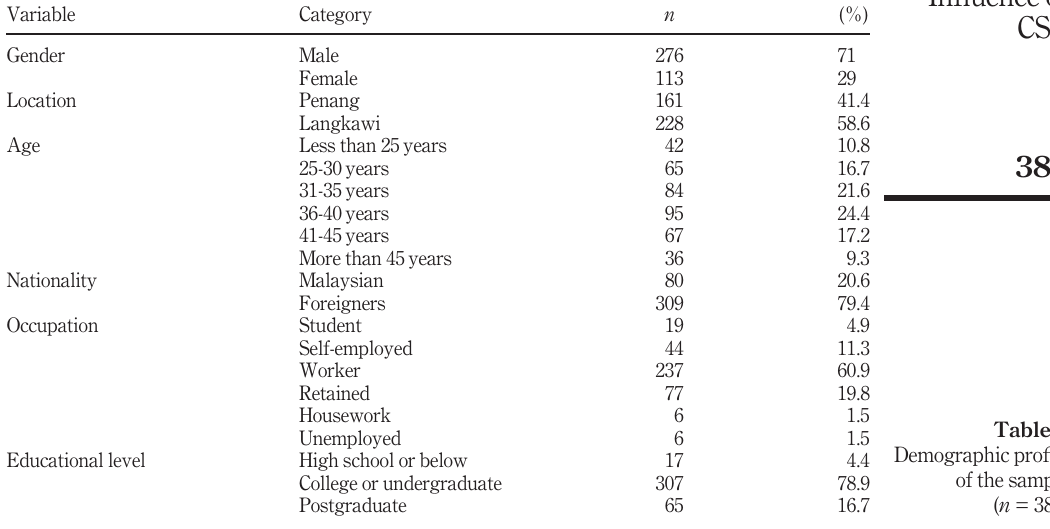
Table I. Demographic pro fi le of the sample ( n =